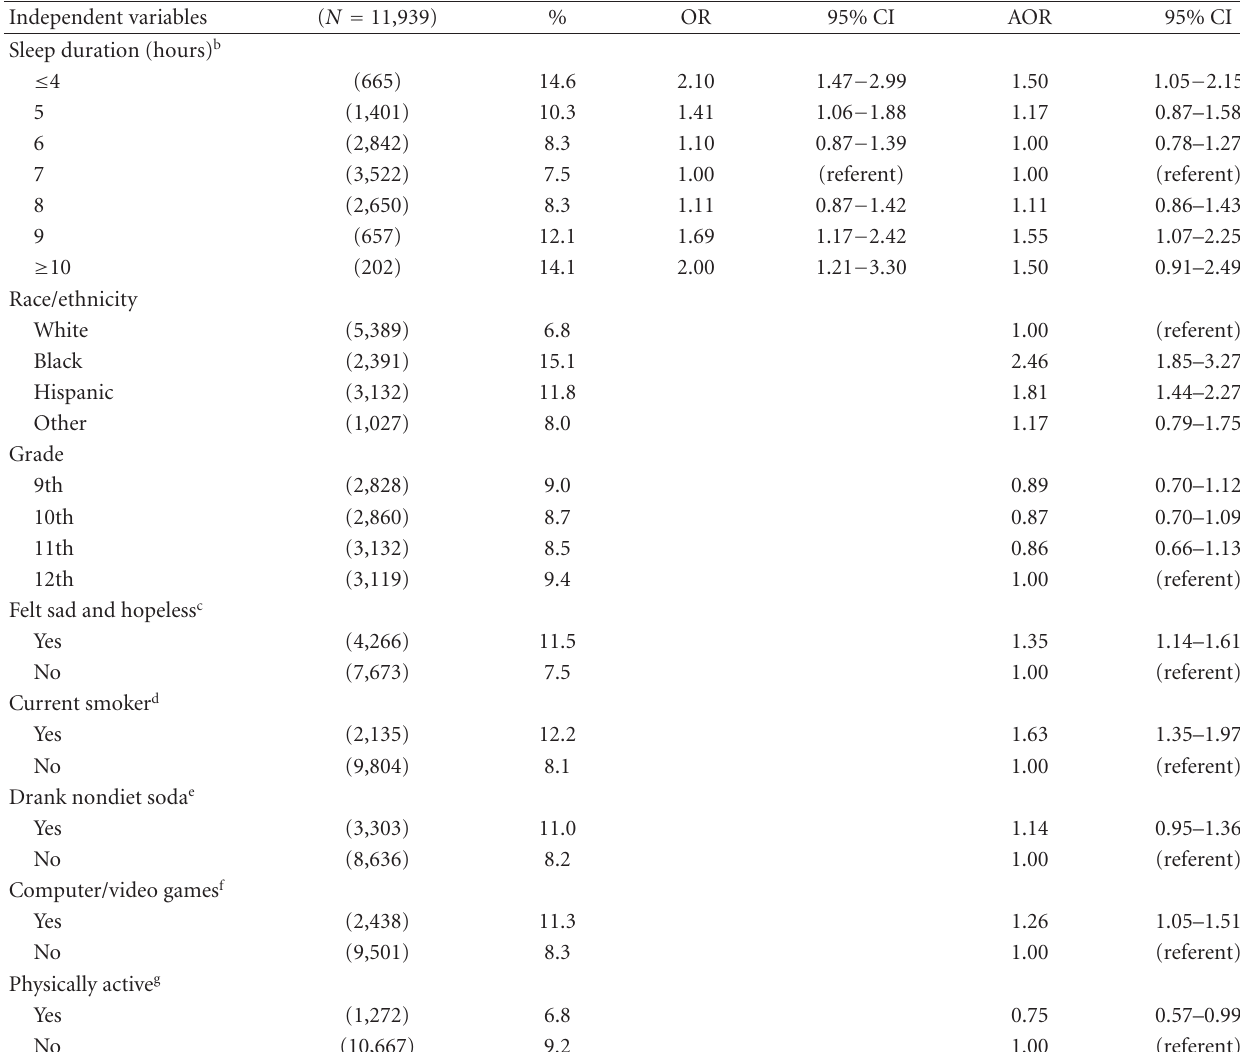
Table 4: Odds ratios for obesity, a by sleep duration—US female high school